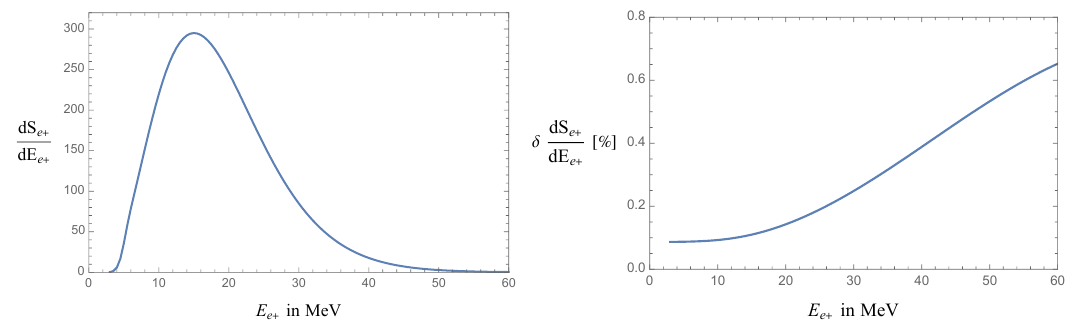
Figure 5 . Energy spectrum of positrons from IBD scattering, considering the antineutrino flux in eq. (4.1) (left plot) and the corresponding 1 σ variation coming from the overall uncertainty on the IBD cross section (right